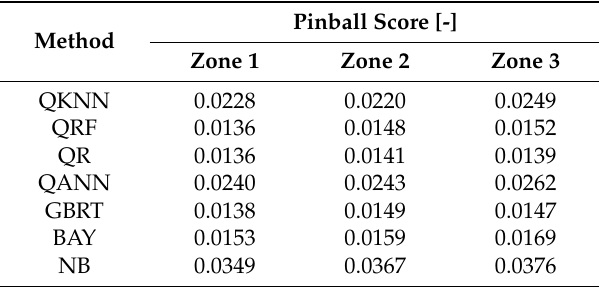
Table 2. Pinball Score values averaged over tasks